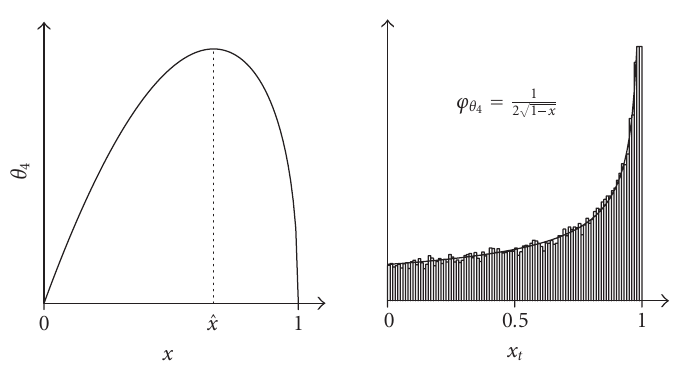
Figure 4.2. Illustration of Example